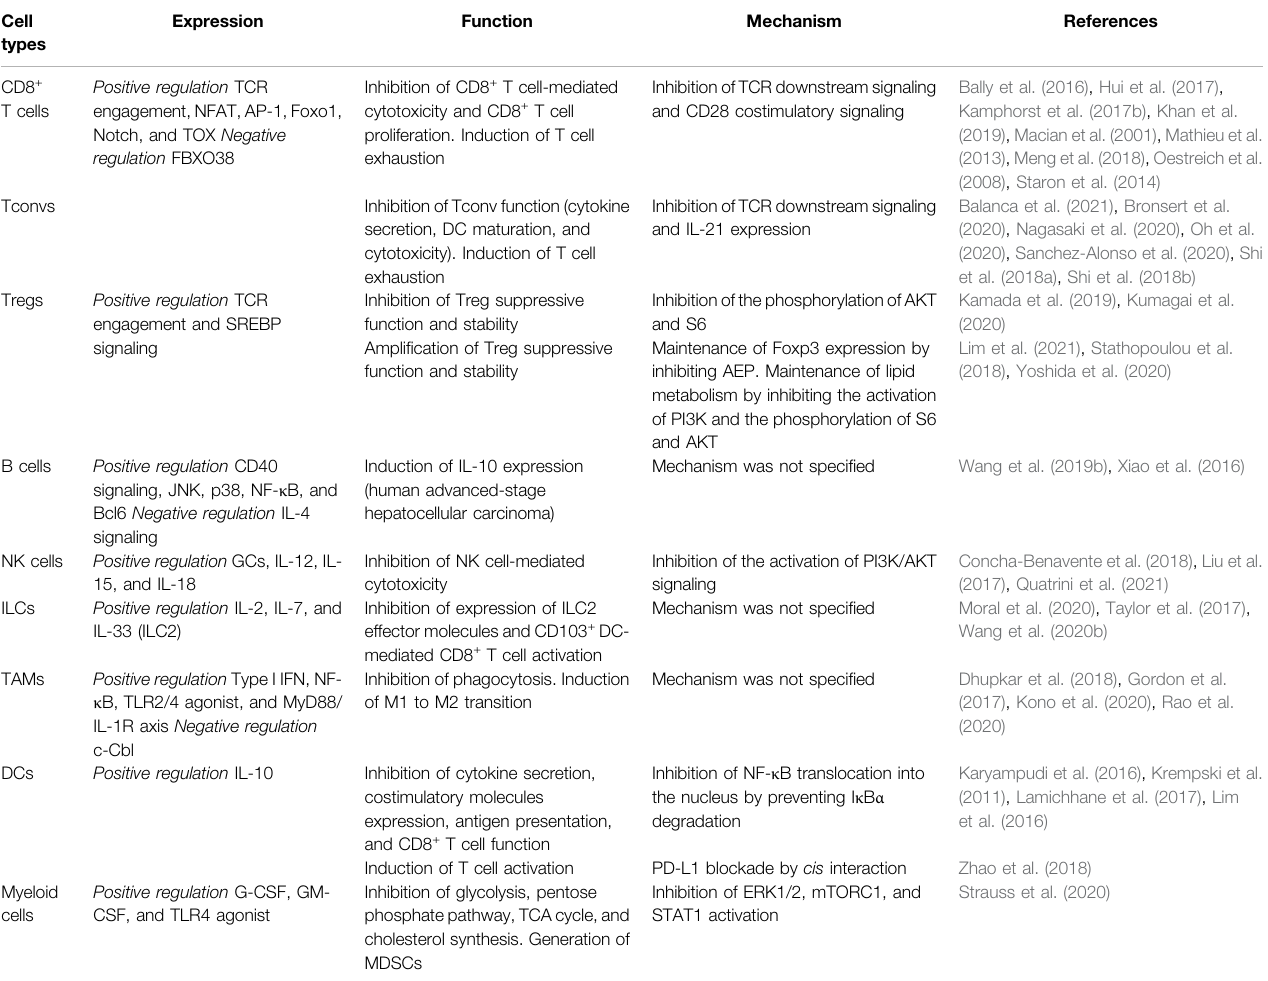
TABLE 1 | PD-1 expressed on tumor-in fi ltrating immune